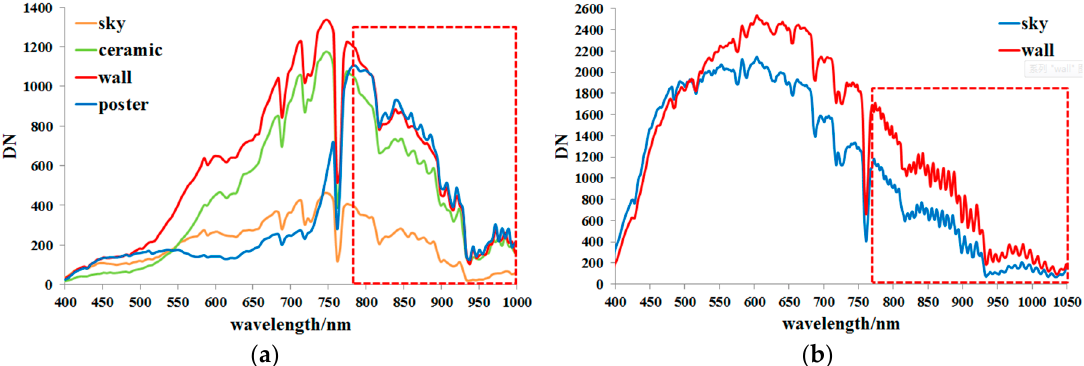
Figure 8. ( a ) Spectral response curves of four typical targets acquired by Camera 1; ( b ) Spectral response curves of two typical targets acquired by Camera 2.